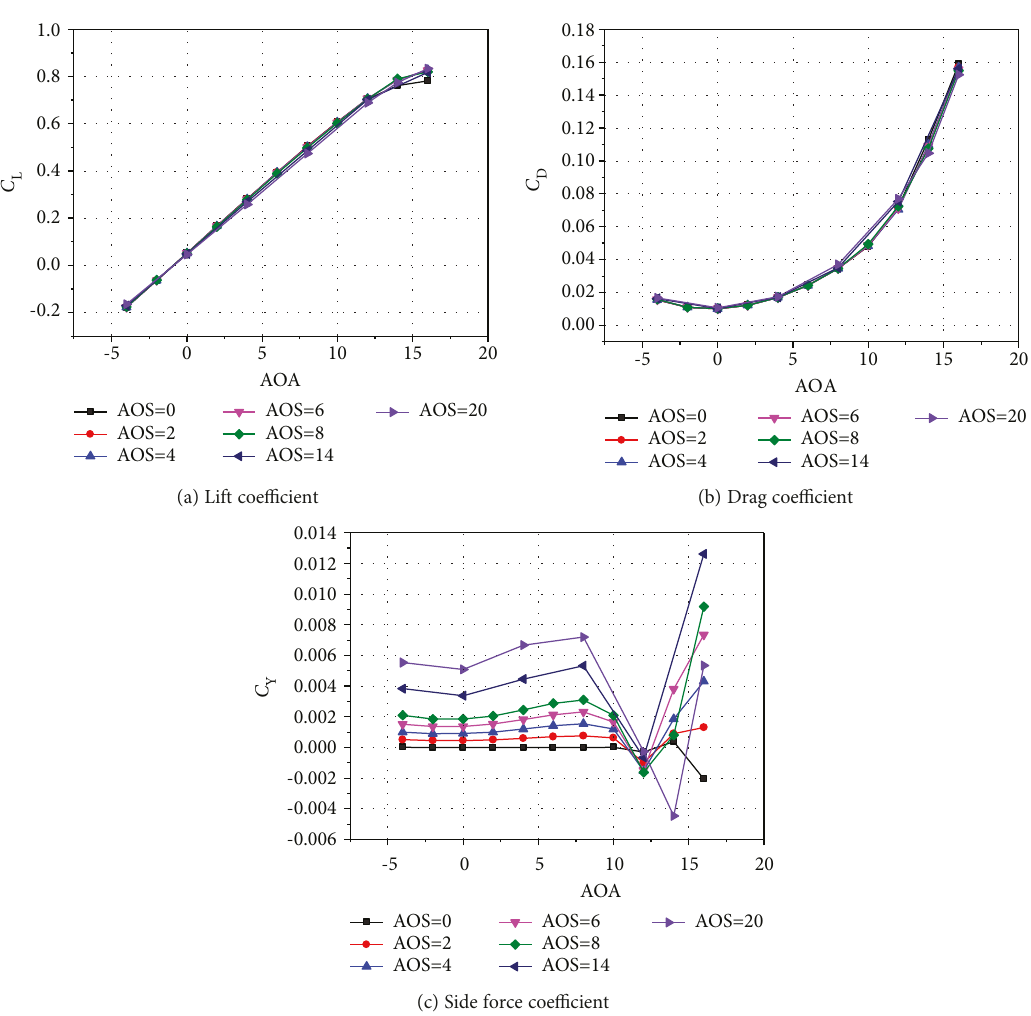
Figure 7: Lift, drag, and side force coe ffi cients for angle of